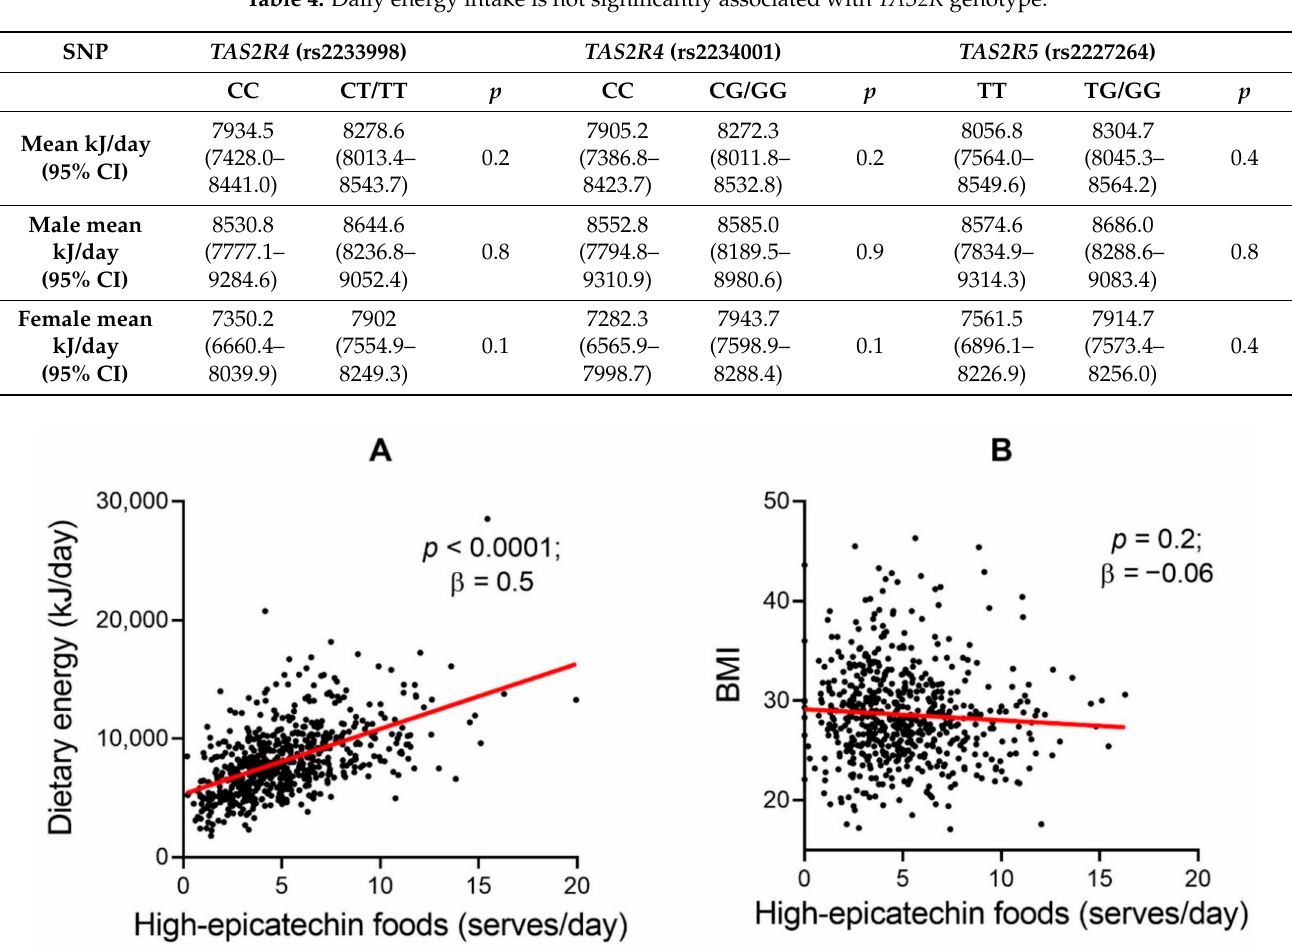
Figure 3. Epicatechin intake is significantly associated with dietary energy intake ( A ), but is not associated with BMI ( B ). Standardised β and p values reported for